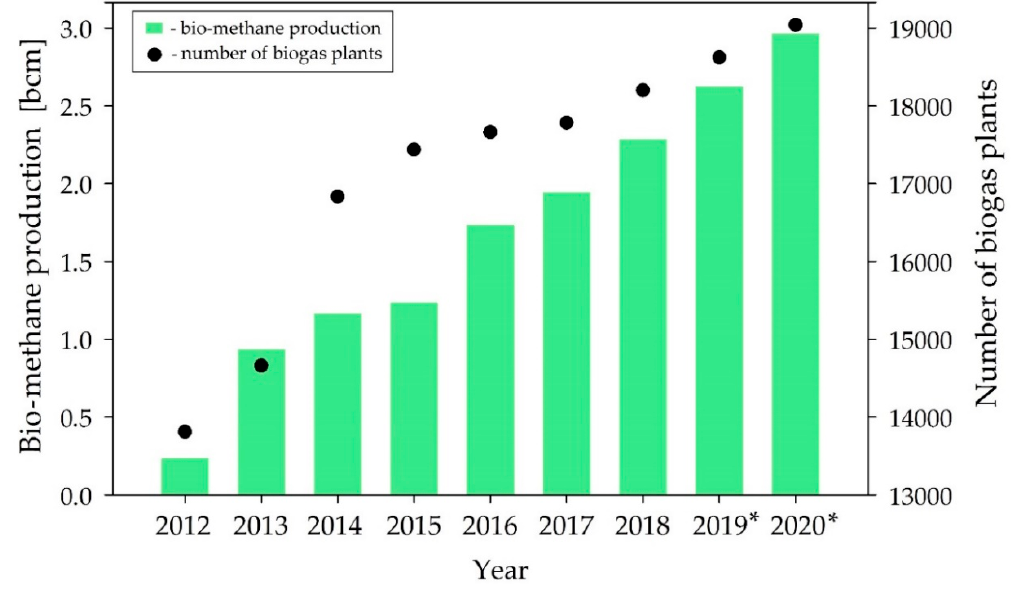
Figure 1. Number of biogas plants and bio-methane production from 2012 to 2020 in the European Union (bcm—billion cubic meters; 2019* and 2020* are estimated values).